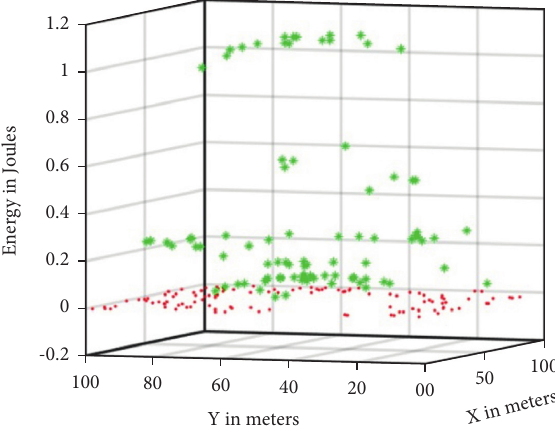
Figure 7: The residual energy of the network after 5000 rounds in 20% of heterogeneous energy of 200